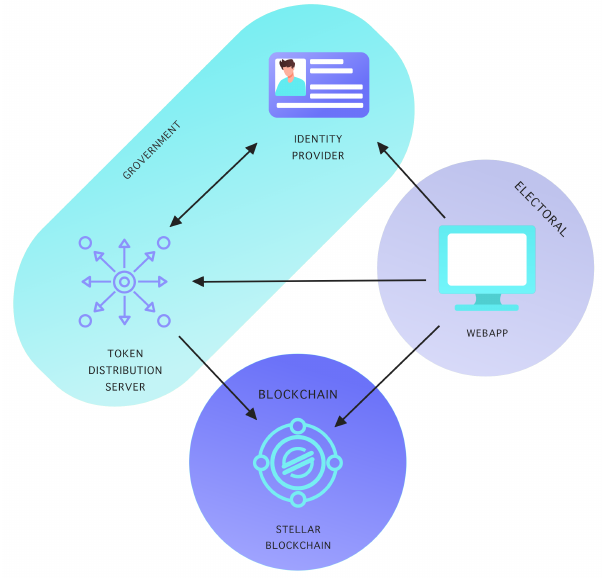
Figure 2. Architecture of our i-Voting